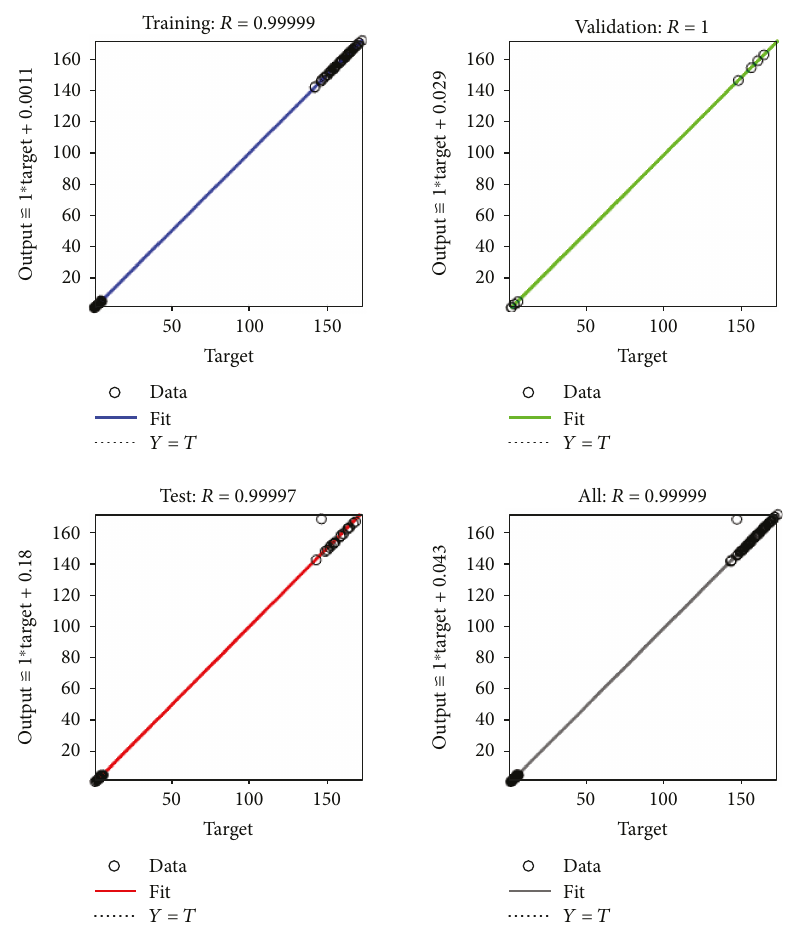
Figure 3: Results using the